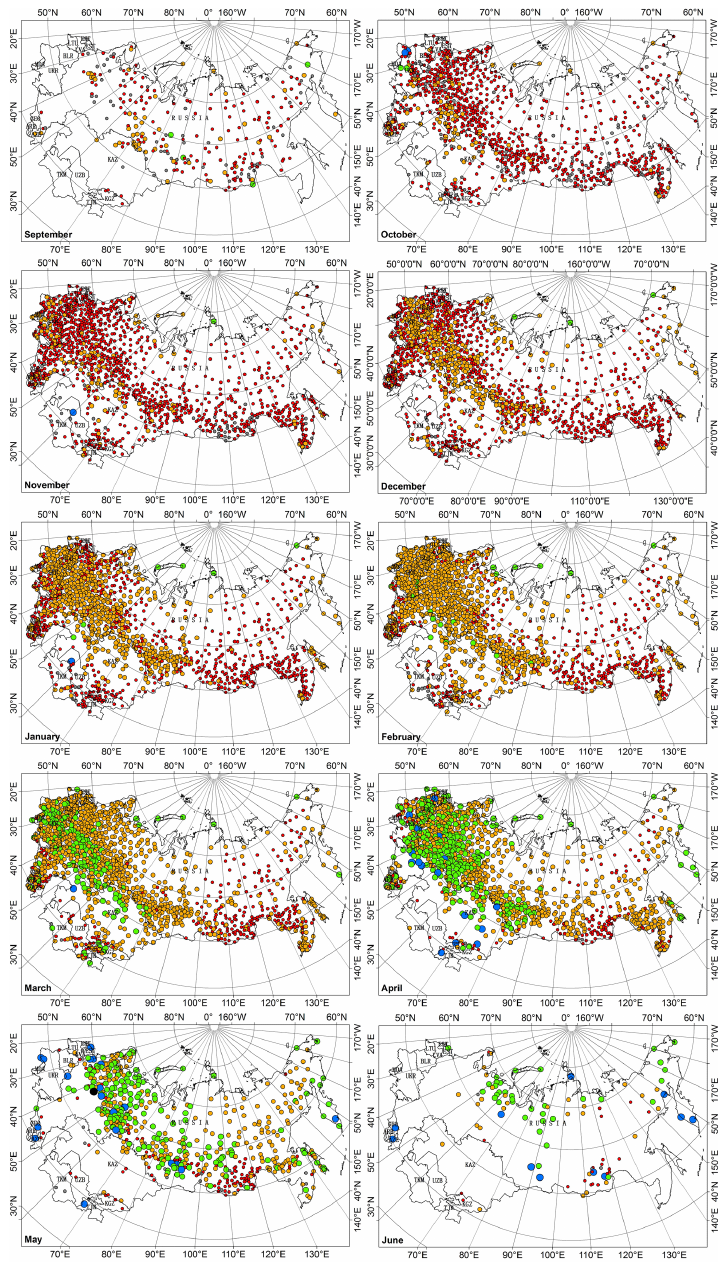
Fig. 4. Spatial distribution of monthly mean snow density for each station during 1966–2008 across the former USSR. Dots represent the value of the monthly mean snow density (gcm − 3 ) of each